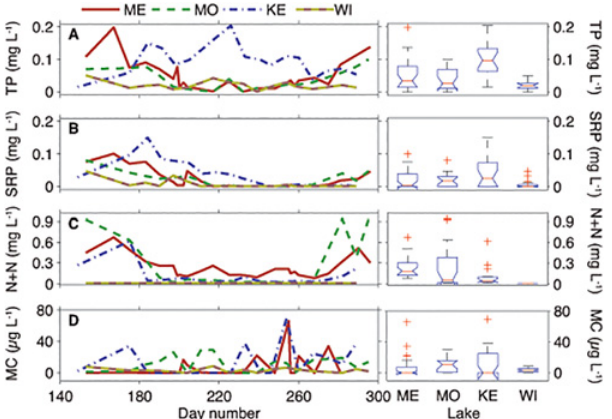
Fig 3. Time-series comparison of total phosphorus (TP), soluble reactive phosphorus (SRP), nitrate plus nitrite (N + N) and total microcystin (Total MC), as well as boxplot results of one-way analysis of variance (ANOVA) of variables between the lakes. Lakes are in order from largest to smallest; left to right: ME = Mendota, MO = Monona, KE = Kegonsa, and WI = Wingra.